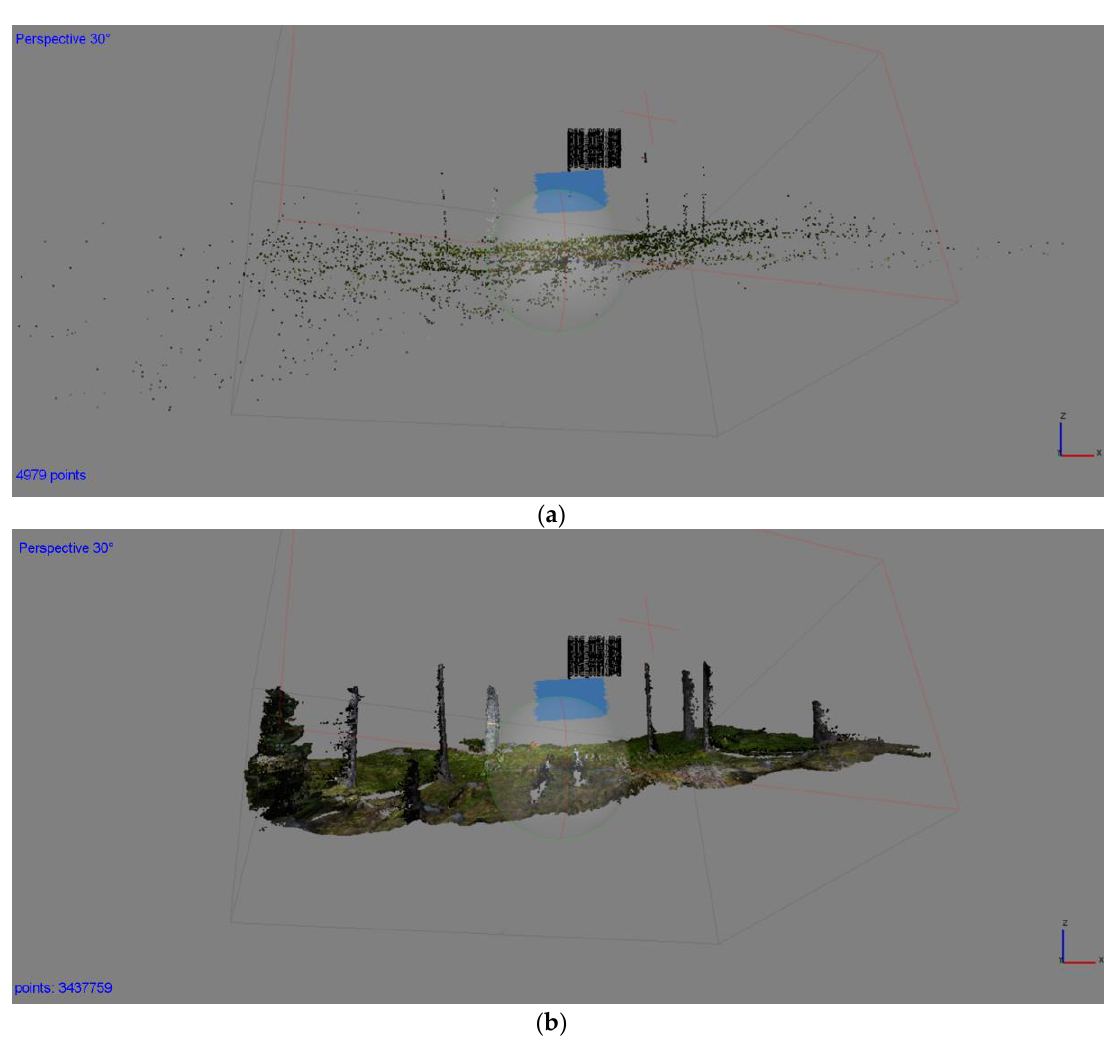
Figure 3. ( a ) Camera poses and tie points after bundle adjustment; ( b ) Dense point cloud.